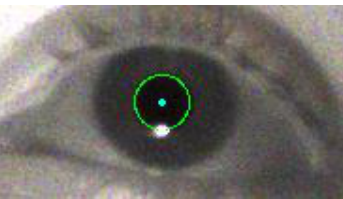
Figure 9. An example of the graininess resulting from adjustments to gain and gamma.